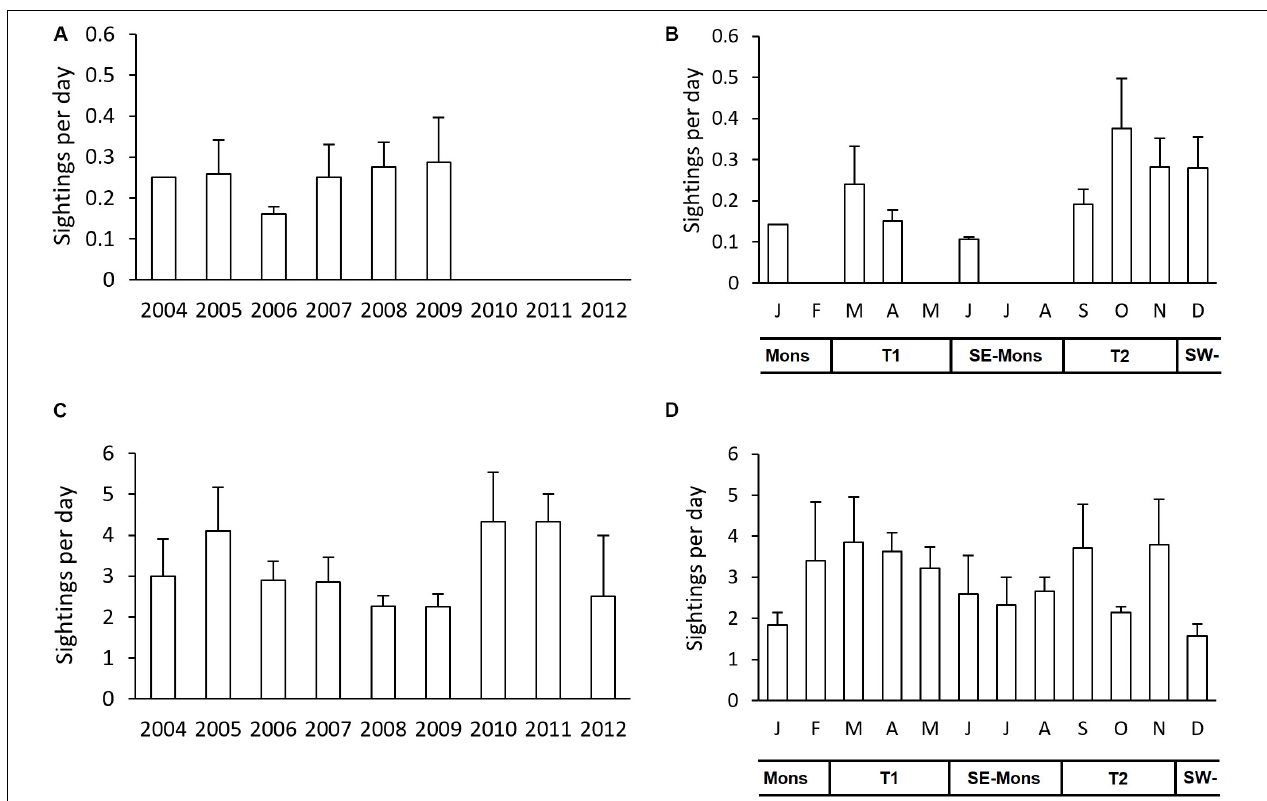
FIGURE 7 | The average sighting frequency per day for each year from May 2004 to May 2012 for large cetaceans (A) and small cetaceans (C) ; and by month for large cetaceans (B) and small cetaceans (D) . T1, Transition 1 season (March–May); SE-Mons, SE Monsoon season (June–August); T2, Transition 2 season (September–November); SW-Mons, SW Monsoon season (December–February). The sighting frequency were calculated from a sub-sample of dataset with surveyed days of 4 or more days per survey. Error bars indicate standard